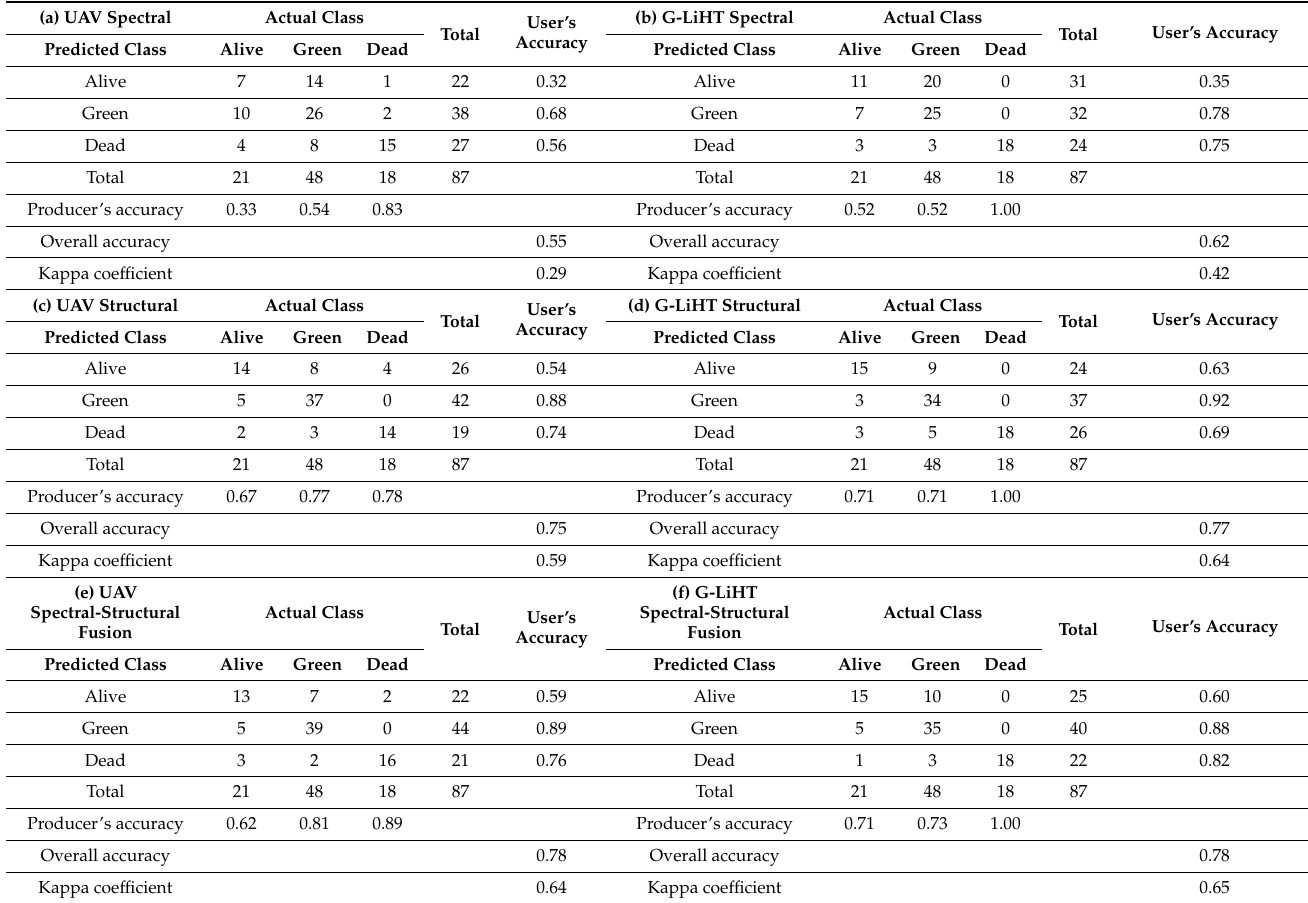
Table 4. Confusion matrices for all models. Results reported at crown level (n = 87) following winner-take-all (i.e., mode) classification. All results shown here are from multiple hold-out cross validation, meaning that each crown was classified 100 times using random subsets of the training data: ( a ) UAV spectral; ( b ) G-LiHT spectral; ( c ) UAV structural; ( d ) G-LiHT structural; ( e ) UAV spectral-structural fusion; and ( f ) G-LiHT spectral-structural fusion.